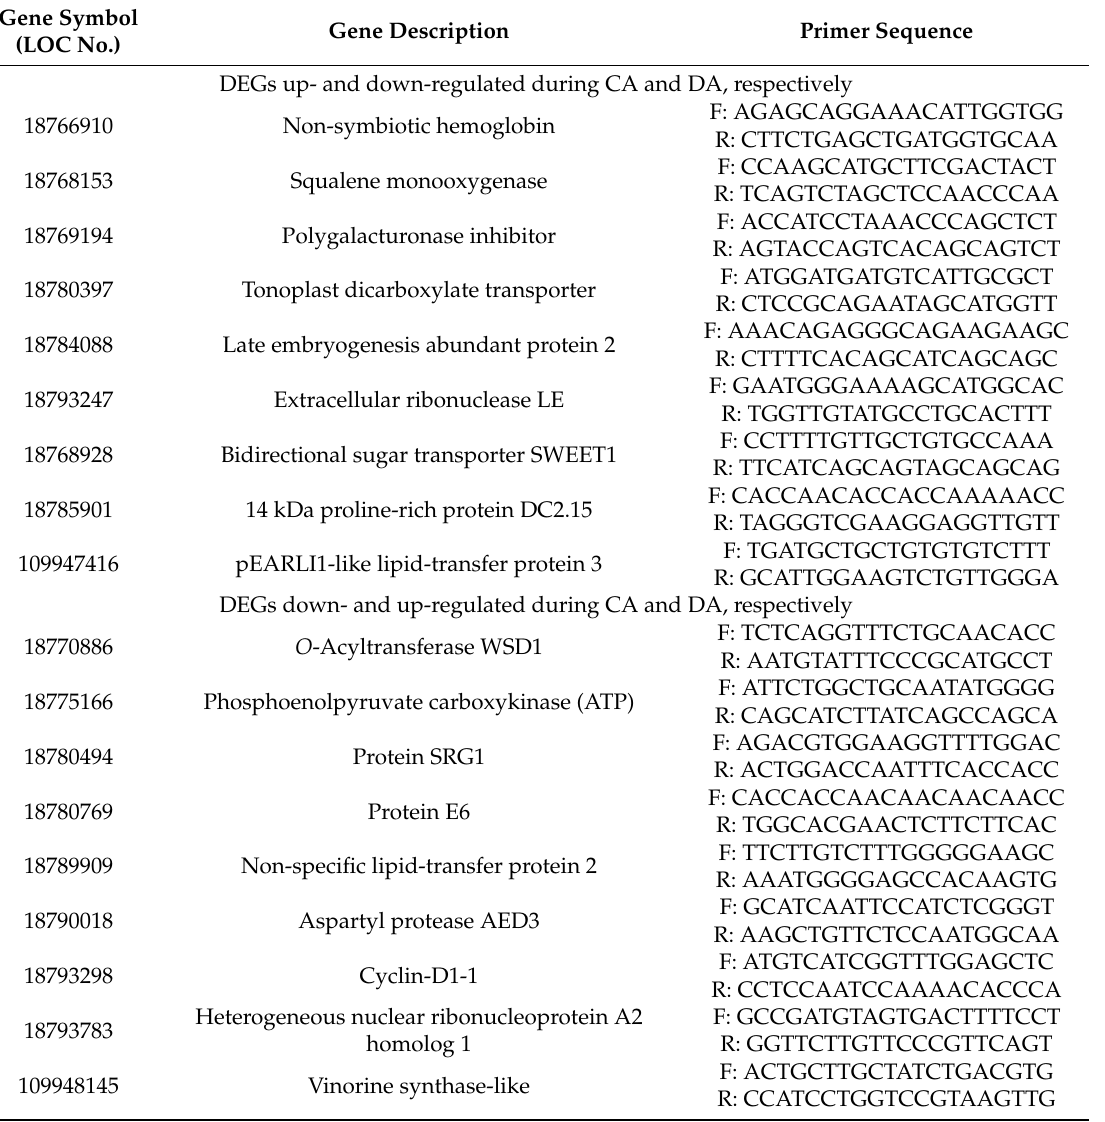
Table 4. Sequences of forward and reverse primers used for qPCR of the selected nine DEGs up- and down-regulated during cold acclimation (CA), from early to late CA, and deacclimation (DA), from late CA to late DA, respectively, and the selected nine DEGs down- and up-regulated during CA, from early to late CA, and DA, from late CA to late DA, respectively, in the ‘Soomee’ peach tree